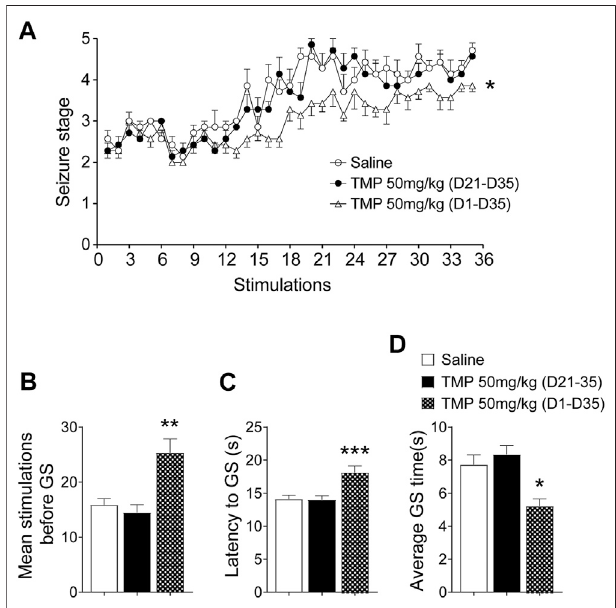
FIGURE 1 | Time dependent effects of TMP on 6 Hz corneal kindling model. (A) ProgressioninseizureseverityduringkindlingacquisitionwithTMP (50 mg/kg, i.p. D21-D35 vs. D1-D35 vs. Saline) administration. Statistical comparison between seizure scores of two groups was performed with a two-way repeated-measures ANOVA followed by a post hoc t test (* p < 0.05). (B) Number of stimulations required to reach the fully kindled state during the acquisition phase of the 6 Hz corneal kindling model. (C) Average latency and (D) average time of generalized seizures, during the acquisition phase of the 6 Hz corneal kindling model. Analyses of stages of kindling were performed with repeated measures two-way ANOVA with Dunnett ’ s multiple comparisons. One-way analysis of variance (ANOVA) was used followed by Dunnett ’ s multiple comparisons in (B – D) . (* p < 0.05, ** p < 0.01 and *** p < 0.001 vs.